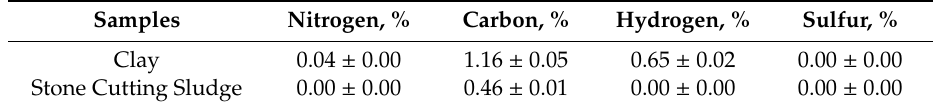
Table 2. Elemental analysis carbon, hydrogen, nitrogen, and sulfur of clay and the stone cutting